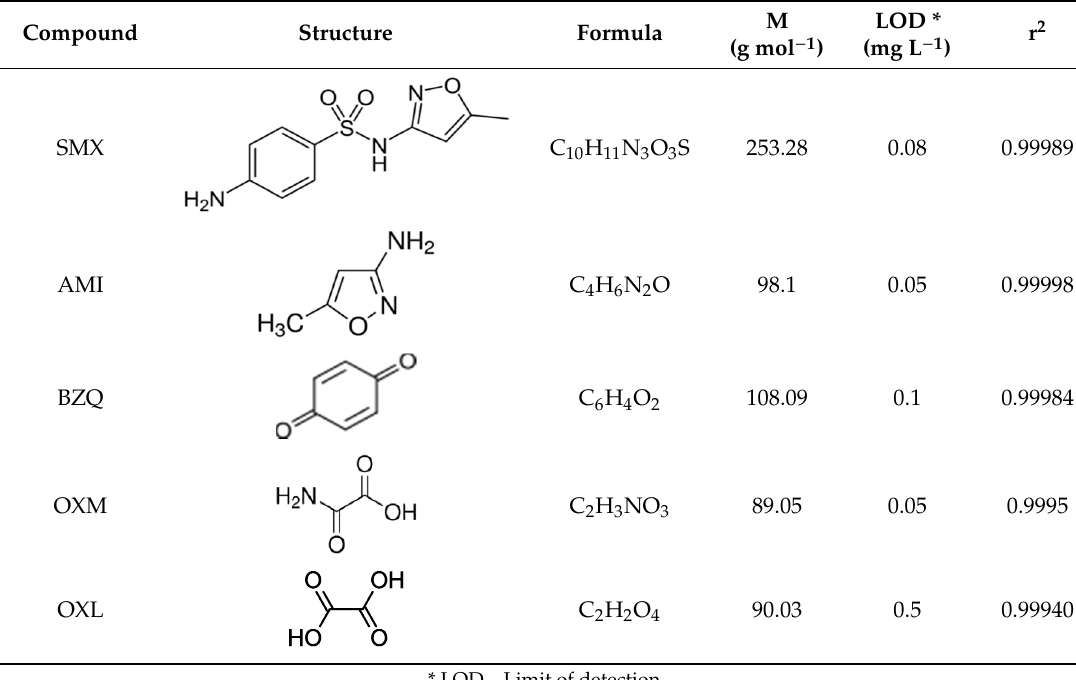
Table 2. Textural properties of the prepared catalysts and crystal properties of TiO 2 and TiO 2 / carbon nanotube (CNT)